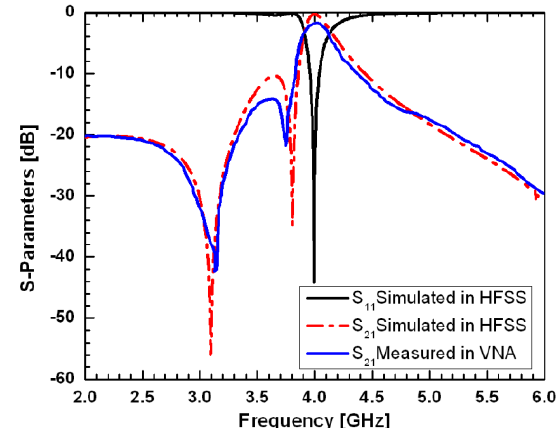
Fig. 11: Simulation and measured results of microstrip bandpass